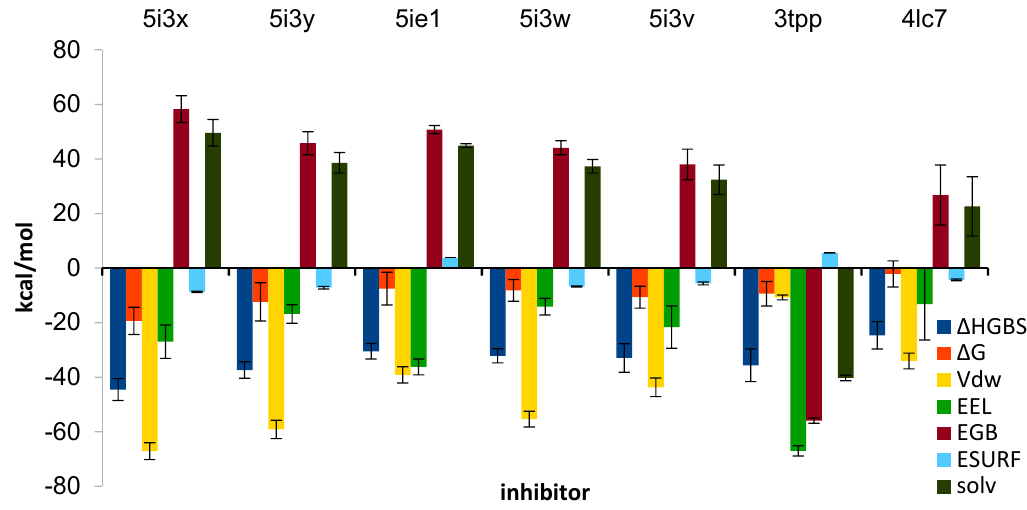
Figure 5. The breakout of binding energy Δ H to its contributing energies for inhibitors under study.